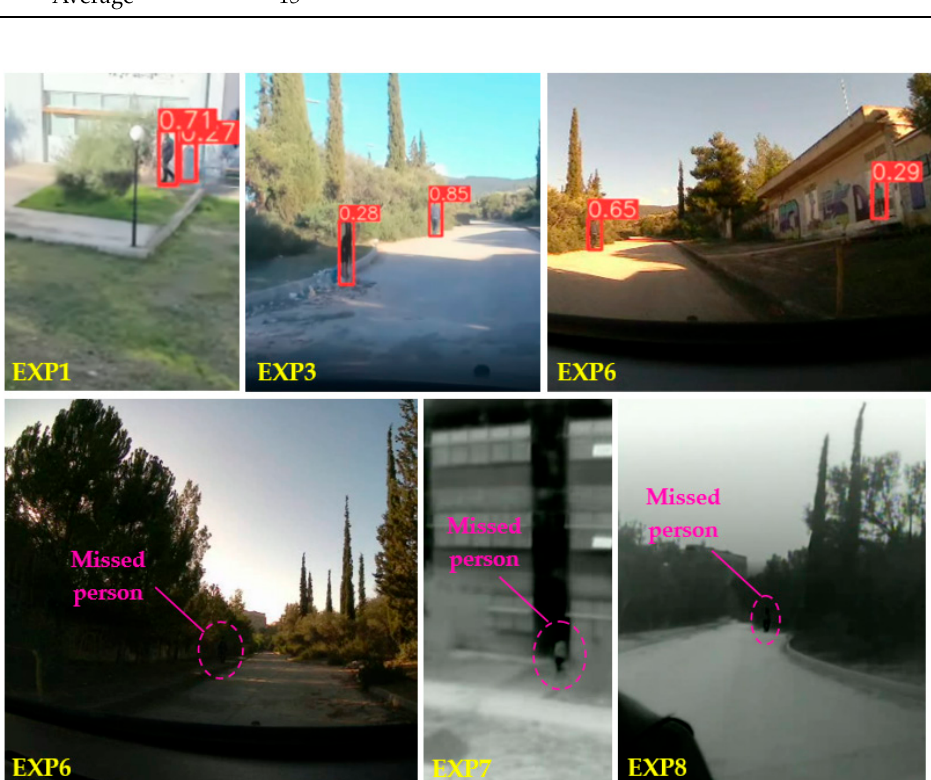
Figure 7. Observed weaknesses of the pre-trained YOLOv5s during the person detection process. Top row: FP entries due to the artificial patterns, such shadows or objects with similar patterns with persons, such as the painted pillar or graffiti; Bottom row: FN entries (magenta ellipse with dashed line) due to the large distance between the camera and person (resulting in a small sized object that is unrecognizable by the algorithm) or with similar RGB (EXP6) or thermal spectral values (EXP7 and EXP8) between background and the person.